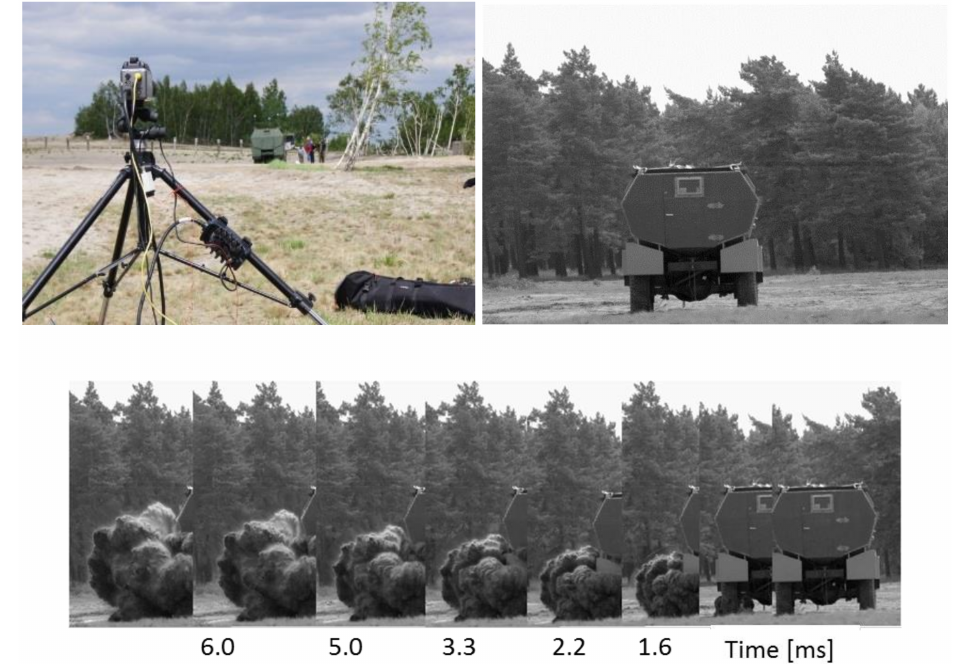
Figure 5. Image recording with high-speed cameras.